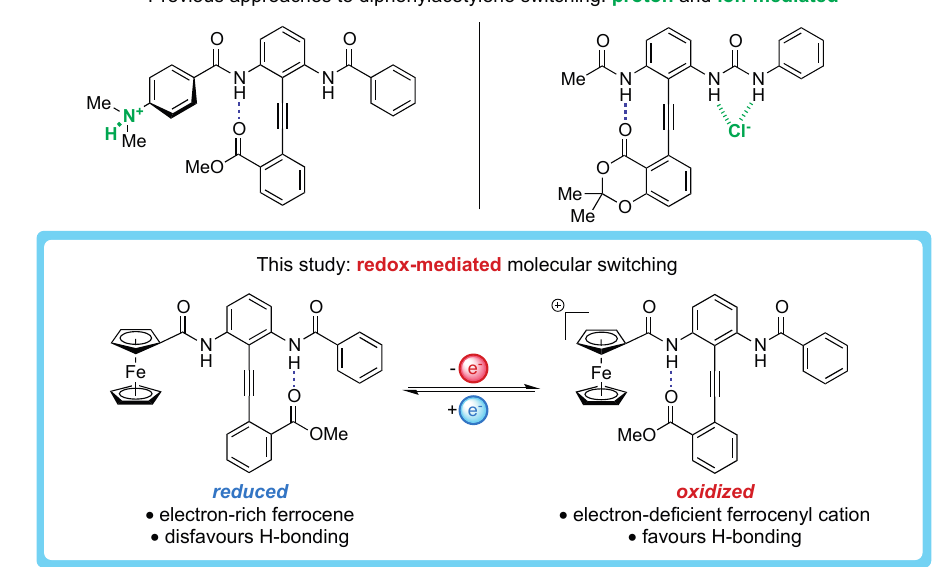
Figure 1. The conceptual transformation from ion-mediated switches to a redox-dependent